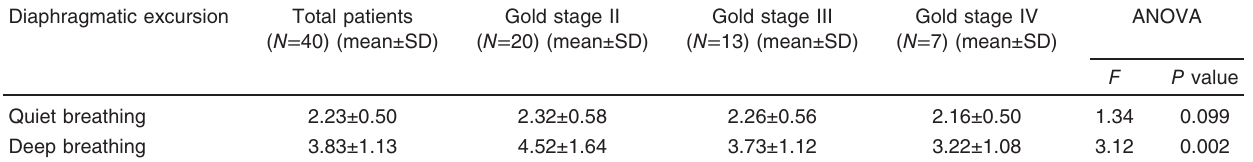
Table 5 Diaphragmatic excursion in patients with chronic obstructive pulmonary disease of different Global Initiative for Chronic Obstructive Lung Disease stages Diaphragmatic excursion